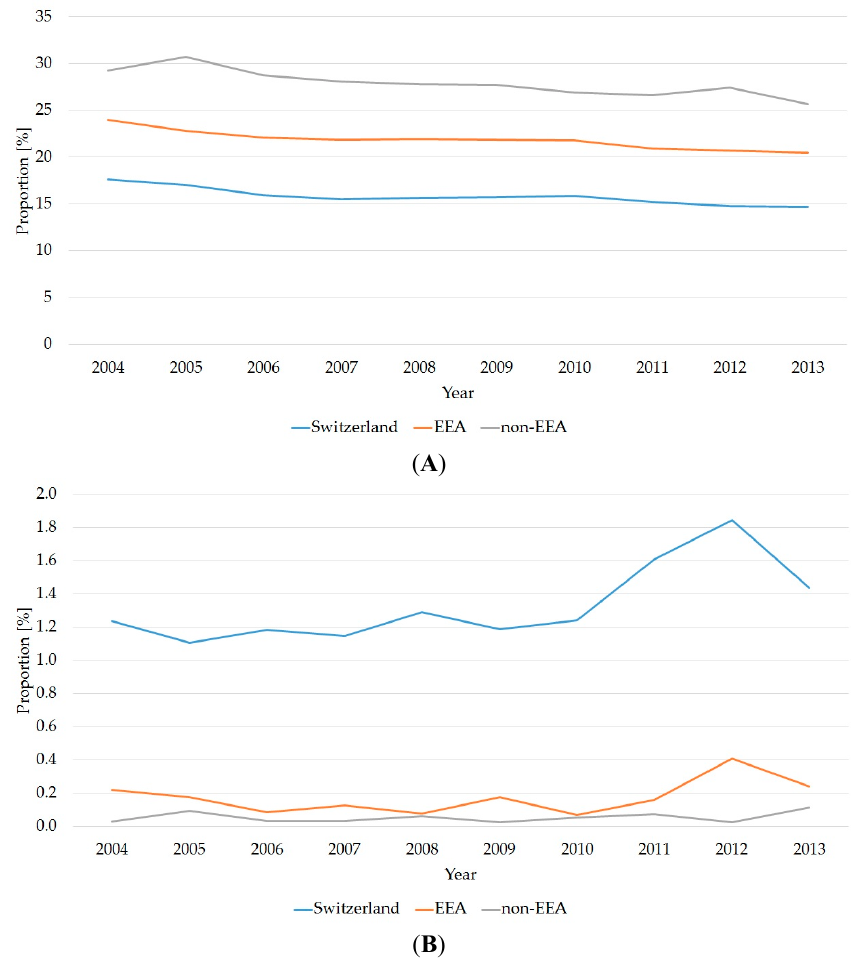
Figure 5. Nationality and different age segments. ( A ) Percentage changes within the patient population of 20–23 year olds over 10 years (Switzerland = 35,638 patients, EEA = 5369 patients, non-EEA = 9620 patients); ( B ) Percentage changes within the patient population aged over 90 years over 10 years (Switzerland = 2710 patients, EEA = 50 patients, non-EEA = 20 patients). EEA: European Economic Area.